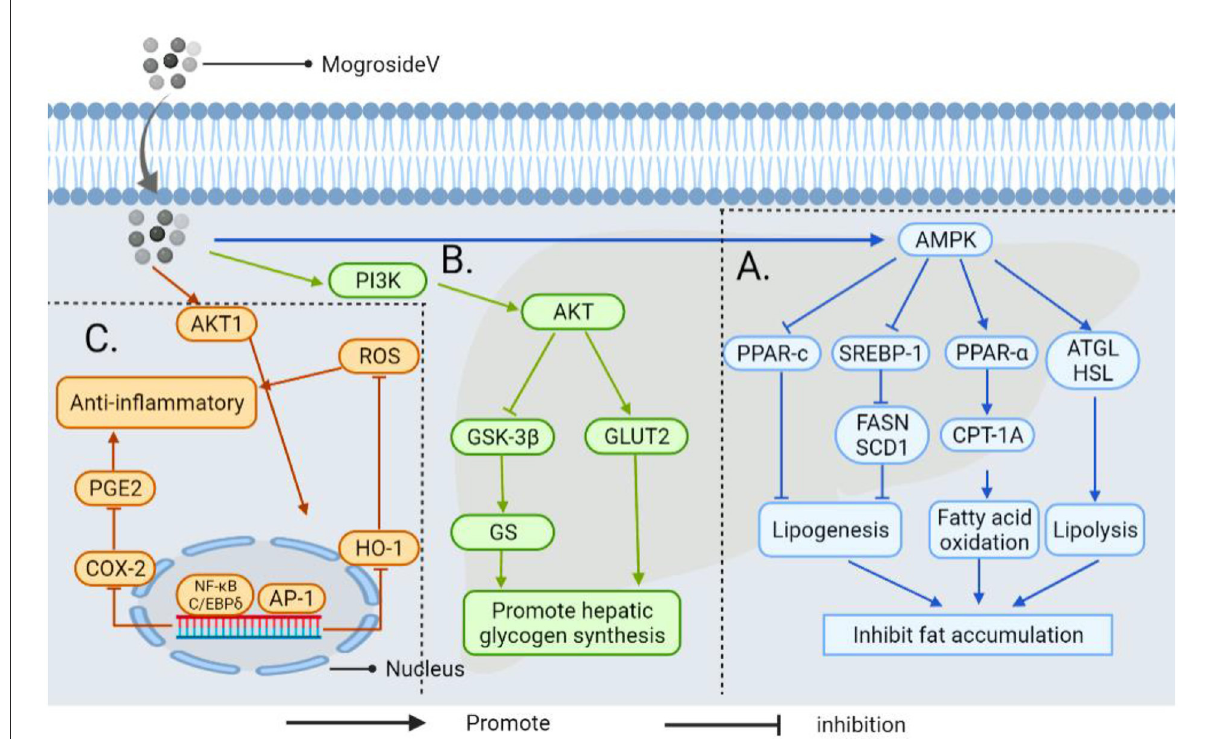
FIGURE11 The mechanism by which androgynous mogroside V inhibits fat accumulation lowers blood glucose and exerts anti-inflammatory effects. (A) In LPS induced inflammatory cells, mogrosideV inhibited the phosphorylation of AKT1(protein kinase B, regulating cell proliferation and growth) and blocked AKT1 mediated NF- κ B and C/EBP δ Pathway, resulting in cyclooxygenase-2 (COX-2) expression, and inhibit prostaglandin E2 (PGE2) production. In addition, dephosphorylation of AKT1 can inhibit transcriptional activator protein-1 (AP-1) to restore hemoglobin oxygenase-1 (HO-1) overexpression to the normal level and reduce reactive oxygen species (ROS) level. Thereby decreasing the occurrence of inflammation. (B) It upregulates phosphatidylinositol-3-kinase (PI3K) and activates downstream AKT, thereby promoting GLUT2 transport and inhibiting the activity of GSK-3 β , thereby enhancing the activity of GS and accelerating glucose uptake by hepatocytes. (C) Mogroside V inhibits fat accumulation by activating AMP-activated protein kinase (AMPK): (I) It can down-regulate the transcription factor sterol-regulatory element binding proteins-1 (SREBP-1) and inhibit fatty acid synthase (FASN) and stearoyl-CoA desaturase 1(SCD1); (II) It can down-regulate peroxisome proliferator-activated receptor-c (PPAR-c) (involved in regulating triacylglycerol synthesis in the liver); (III) It regulates the activation of carnitine Palmitoyltransferase-1A (CPT-1A) by PPAR- α , which is involved in mitochondrial transport and oxidation of fatty acids. Thus improving liver steatosis and inhibiting fat accumulation; (IV) It enhances the expression of genes for adipose triglyceride lipase (ATGL) and hormone-sensitive lipase (HSL) in the liver to promote